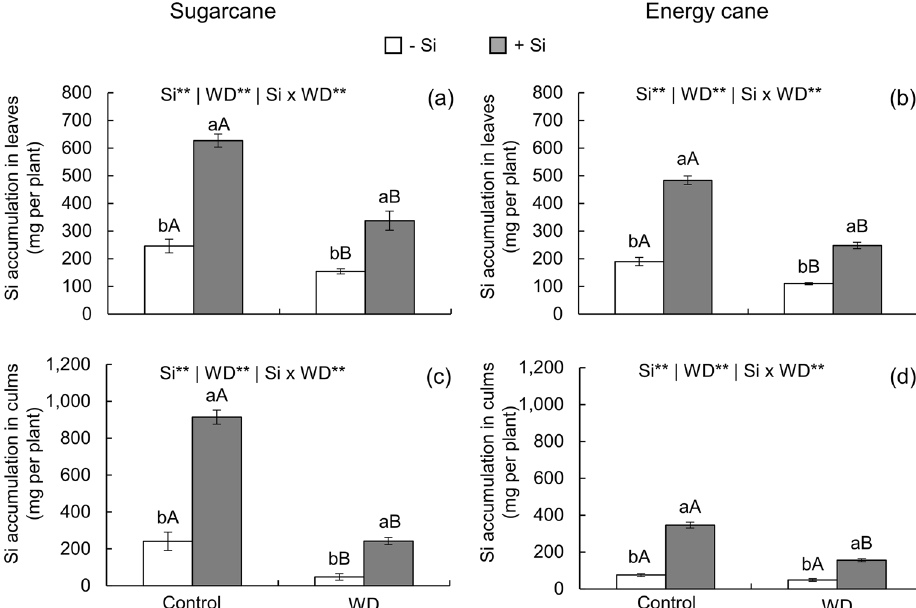
Figure 1. Silicon (Si) accumulation in leaves and culms of sugarcane ( a , c ) and energy cane ( b , d ) in the absence of Si (-Si) and with Si applied via fertigation associated with foliar spraying (+ Si) under adequate water regime (control) and severe water deficit (WD) for a period of 7 to 160 days after transplanting. ** : significant at 1% probability by the F-test. Different lowercase letters indicate differences in relation to Si in the same water regime; different capital letters indicate differences in relation to the water regime in the same conditions of Si supply, both by the Tukey test. Bars represent the standard error of the mean; n =